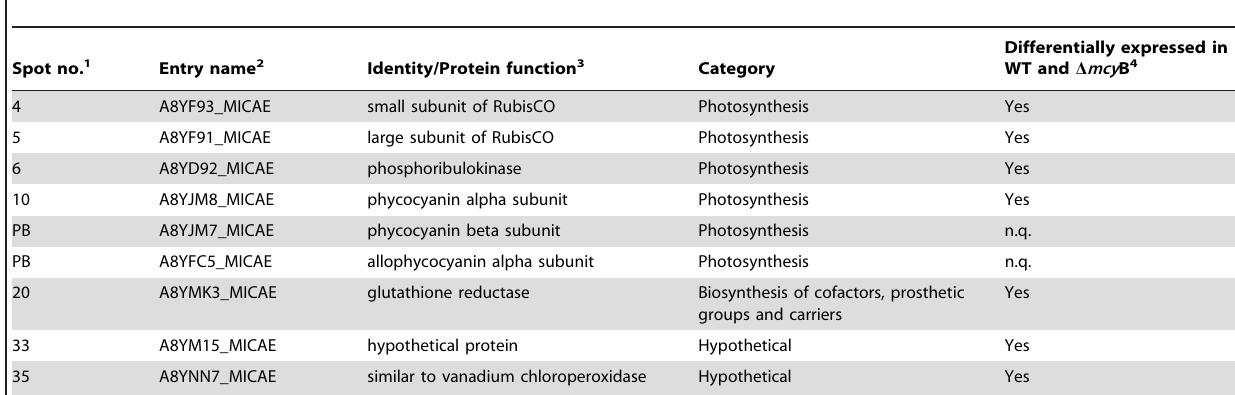
Table 2. List of microcystin binding proteins in extracts of the wild type M. aeruginosa PCC 7806 (WT) which were identified by 2D electrophoresis and subsequent immunoblots against